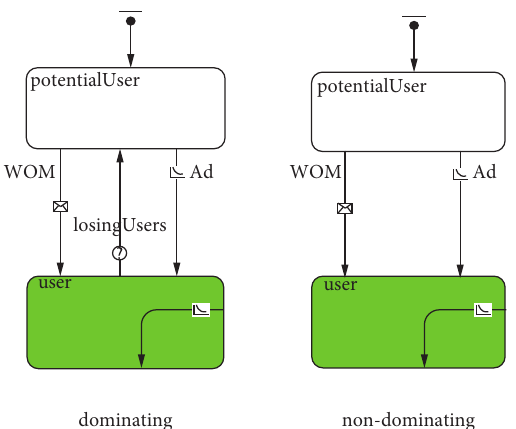
Figure 15: Customer’s state chart in Bass diffusion model developed by dominating and nondominating